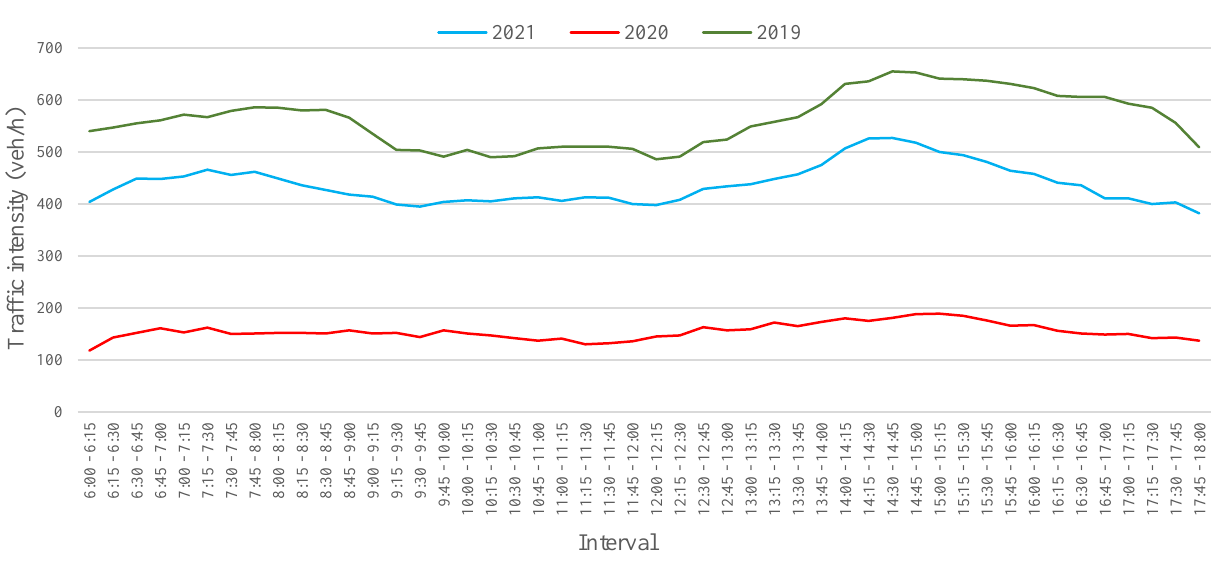
Figure 2. The daily traffic volume distribution of the average workday in individual years.